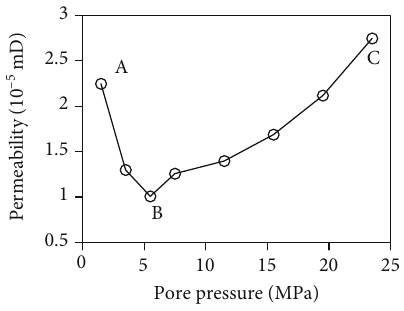
Figure 4: Relationship of permeability and pore